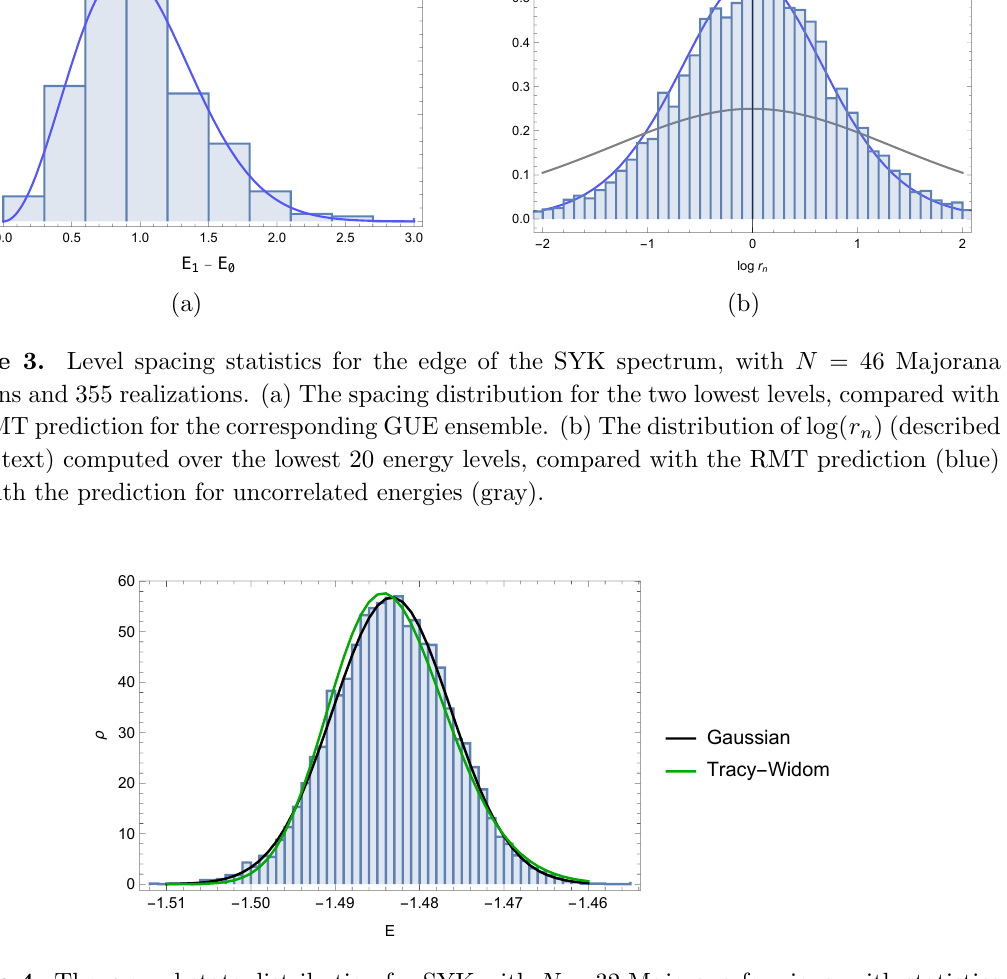
Figure 4. The ground state distribution for SYK with N = 32 Majorana fermions, with statistics collected over 10 4 realizations. Solid lines show the Gaussian and Tracy-Widom distributions with mean and variance chosen to (cid:12)t the